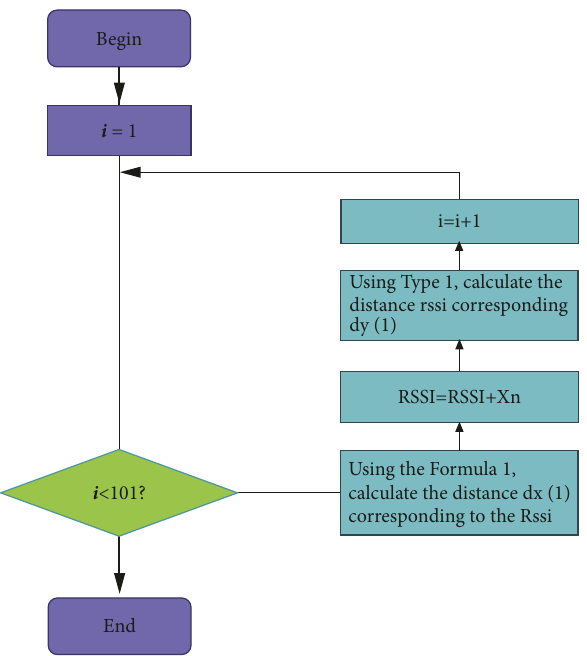
Figure 7: The derivation process of locating distance.